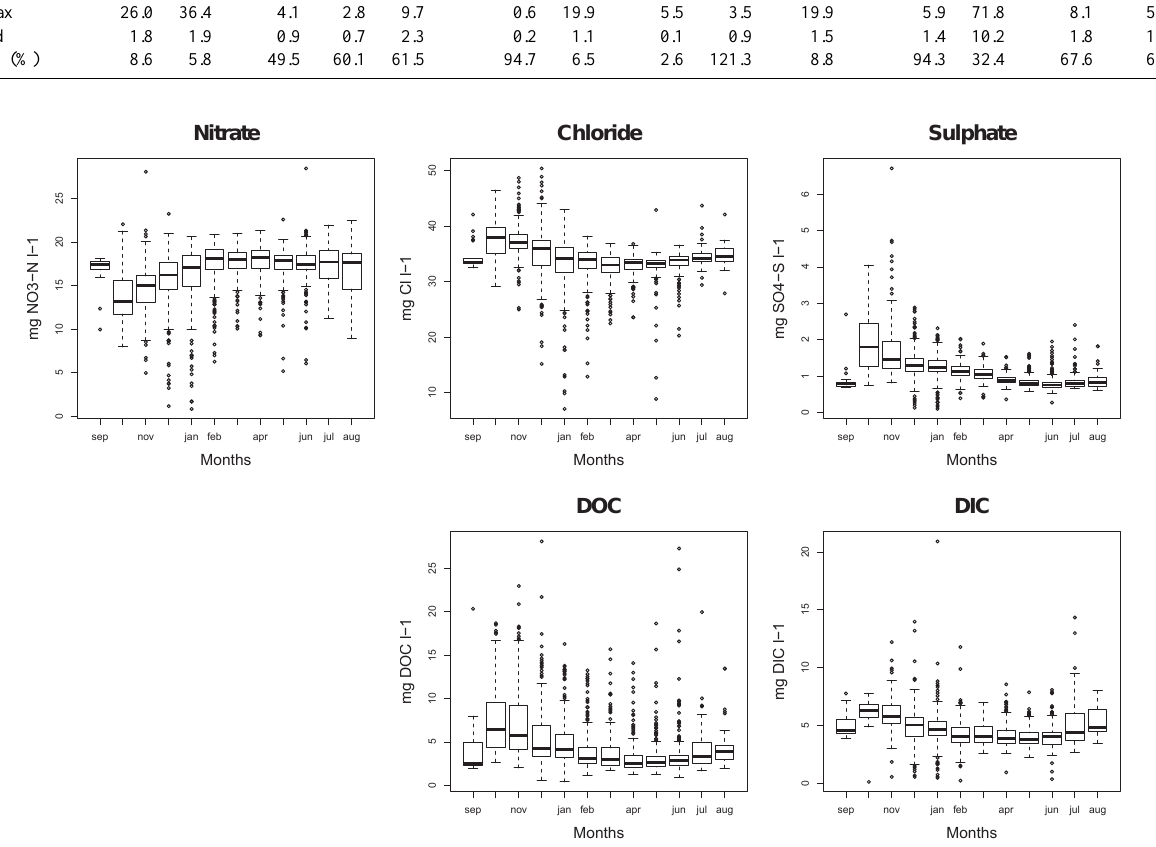
Fig. 3. Boxplots of monthly concentrations of nitrate, chloride, sulphate, dissolved organic carbon (DOC), and dissolved inorganic carbon (DIC) based on daily data from the 10yr dataset. The middle bar represent the median, the lower limit the 1st quartile ( q 0 . 25 ) and the upper limit the 3rd quartile ( q 0 . 75 ) . The lower and upper dashed lines are, respectively, the 1st quartile minus 1.5 times interquartile range and the 3rd quartile plus 1.5 times the interquartile